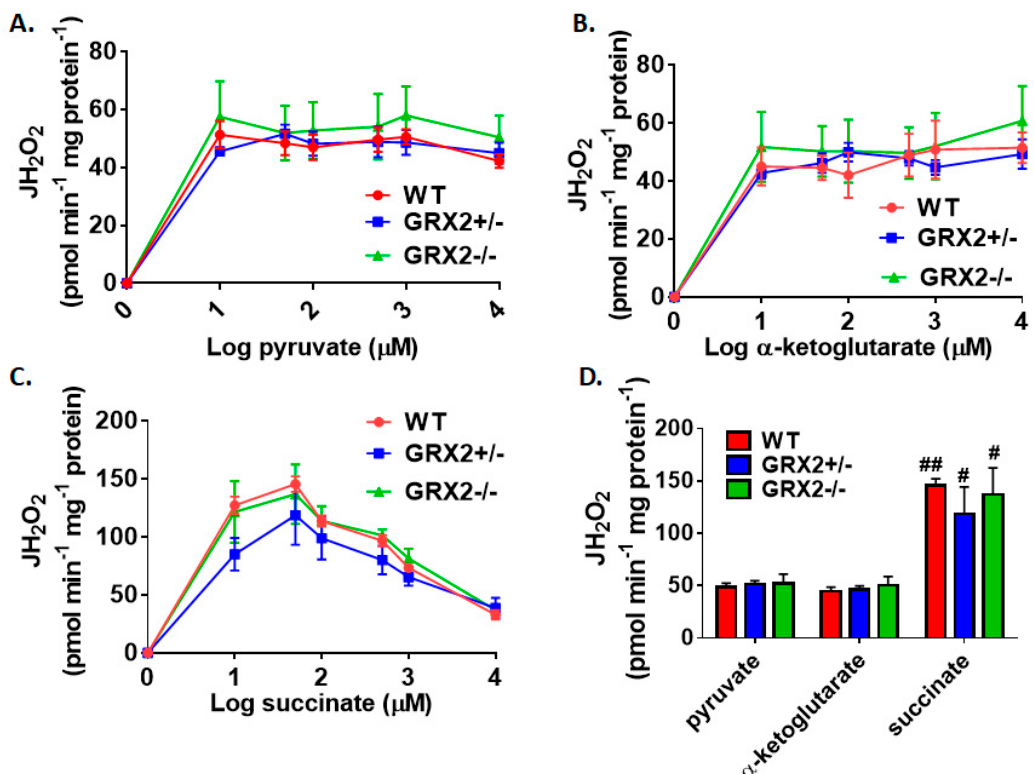
Figure 1. Deletion of the Grx2 gene does not alter the rate of H 2 O 2 production by liver mitochondria isolated from female mice. Rates of production by mitochondria energized with pyruvate ( A ), α -ketoglutarate ( B ), or succinate ( C ) at a concentration range of 10–10,000 µ M. ( D ). Comparison of the rates of reactive oxygen species (ROS) production in mitochondria isolated from wild-type (WT), GRX2 +/ − , and GRX2 − / − mice oxidizing 50 µ M pyruvate, α -ketoglutarate, or succinate. n = 4, mean ± SEM (standard error of mean), 2-way ANOVA with a post-hoc Tukey’s test. #: p ≤ 0.05, ##: p ≤ 0.01.